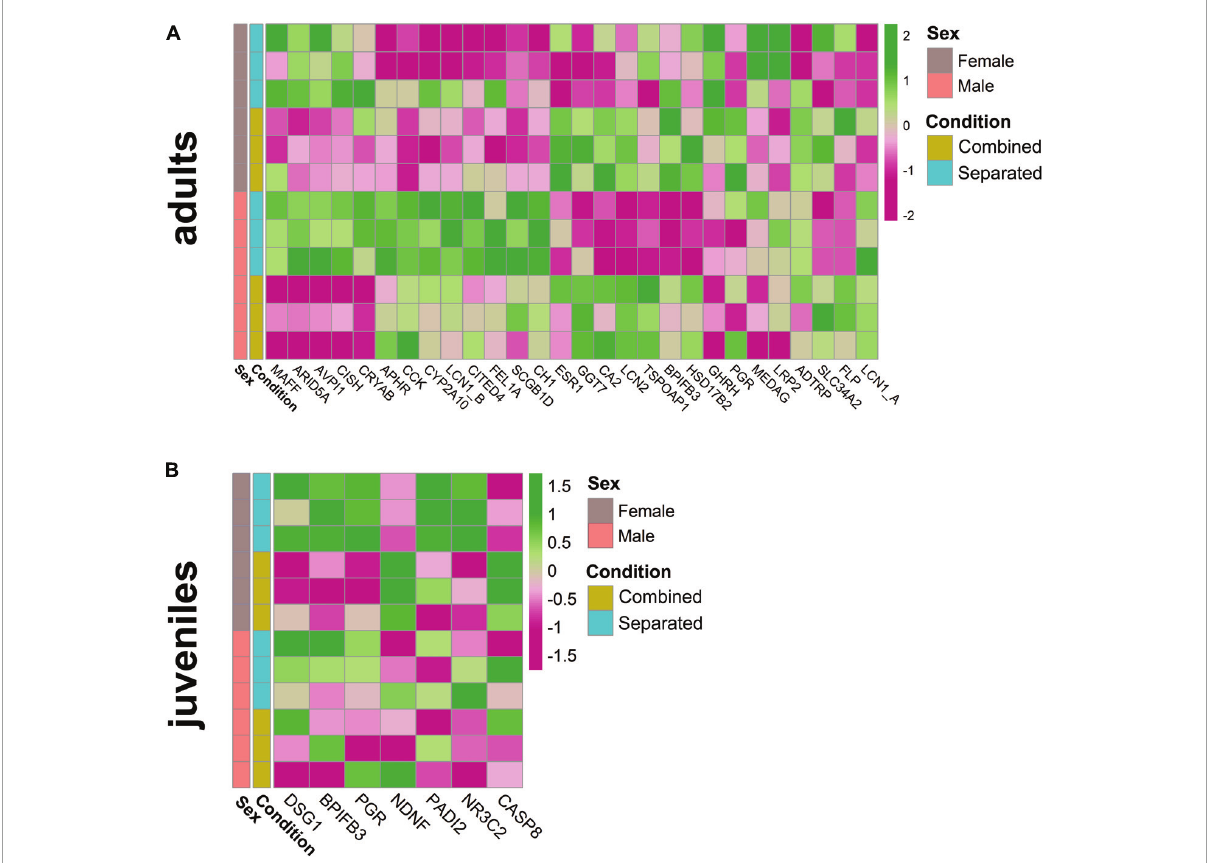
FIGURE3 Heatmap of relevant reproduction-related genes in (A) adult male and female and (B) juvenile female rabbit VNO, comparing sex-separated vs. sex-combined conditions (SF vs.